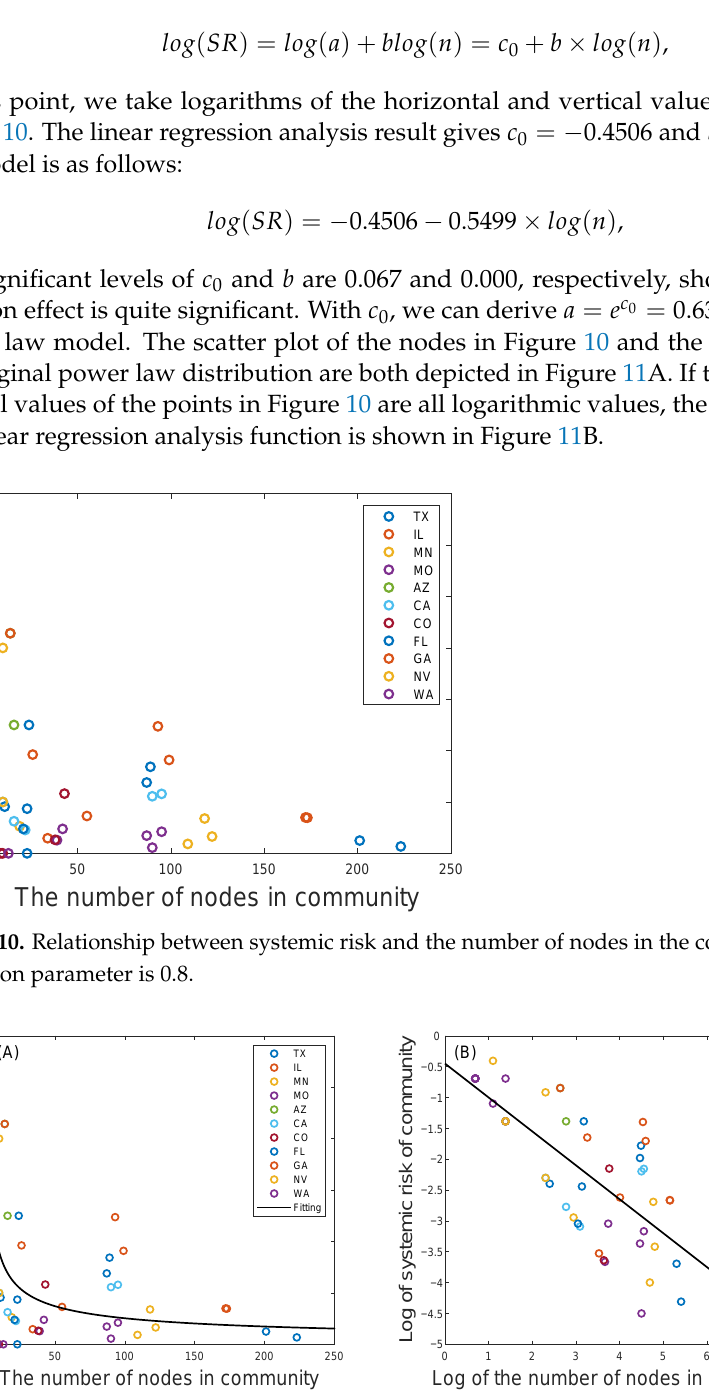
Figure 11. The results of regression analysis on the nodes in Figure 10. ( A ) shows the power law distribution of points in Figure 10. ( B ) shows the result after taking the logarithm to the horizontal and vertical values of points in ( A